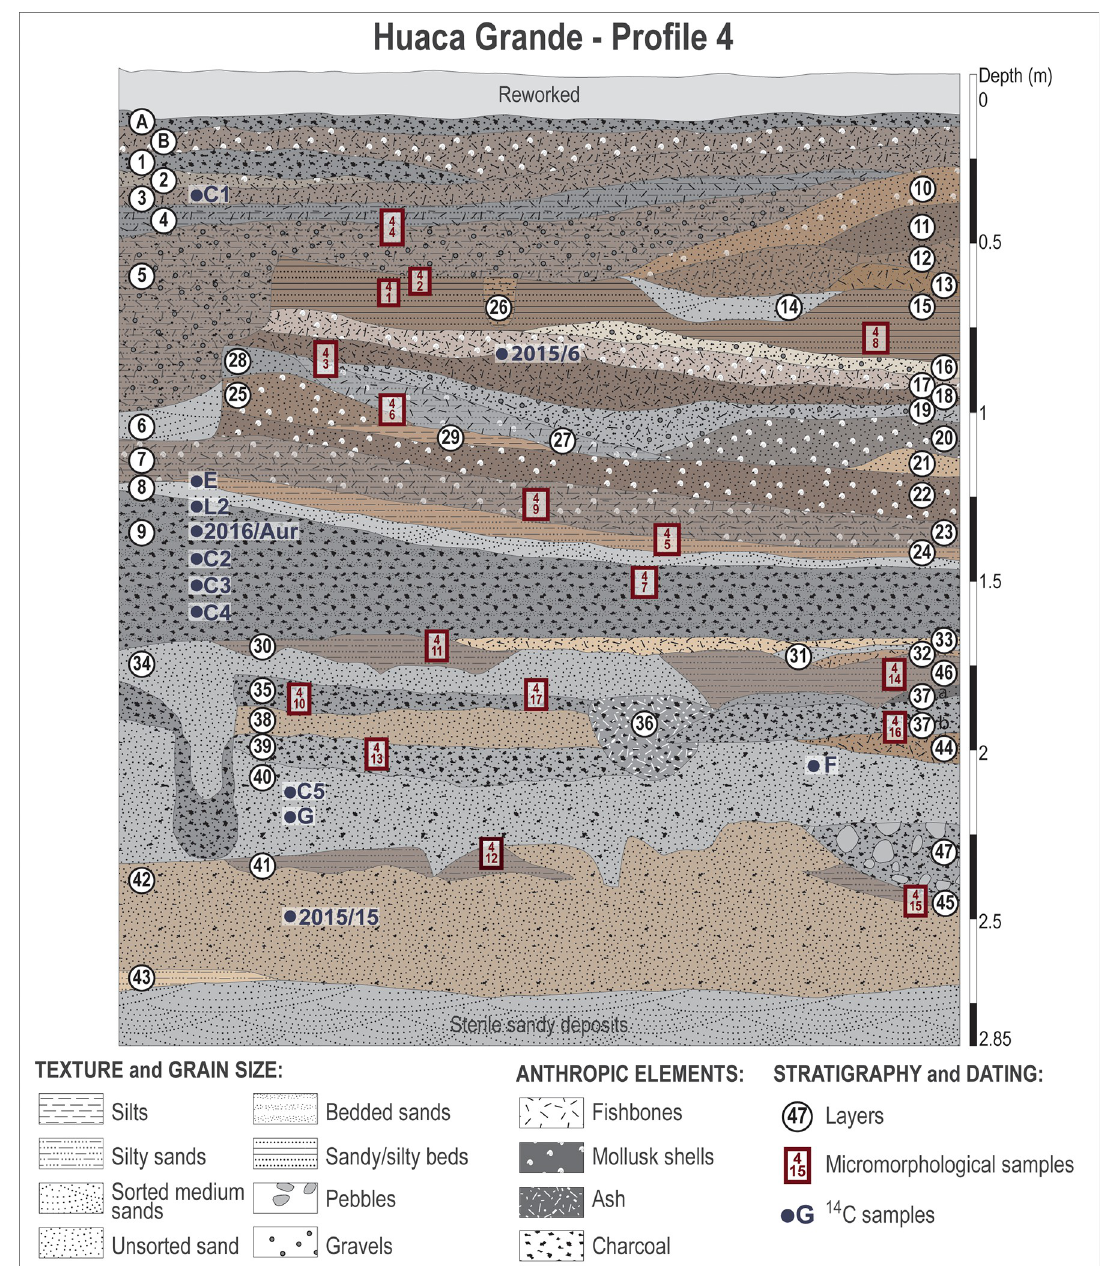
Fig 2. Stratigraphic sequence of profile 4, west wall of trench A4.1, showing the locations from which the micromorphological and radiocarbon dating samples were taken. distributed over three morpho-functional segments of the bony pelvis: the pre-auricular region, the shape of the greater ischial incisure, the sexual shape of the compound arch, the shape of the inferior border and the relative length of the pubis and ischium. The second method is morphometric based on metric variability with a reliability varying between 98.7% and 100% [40]. It is based on the principle of discriminant analysis from four to ten variables to determine the probability of belonging to a male or female group.